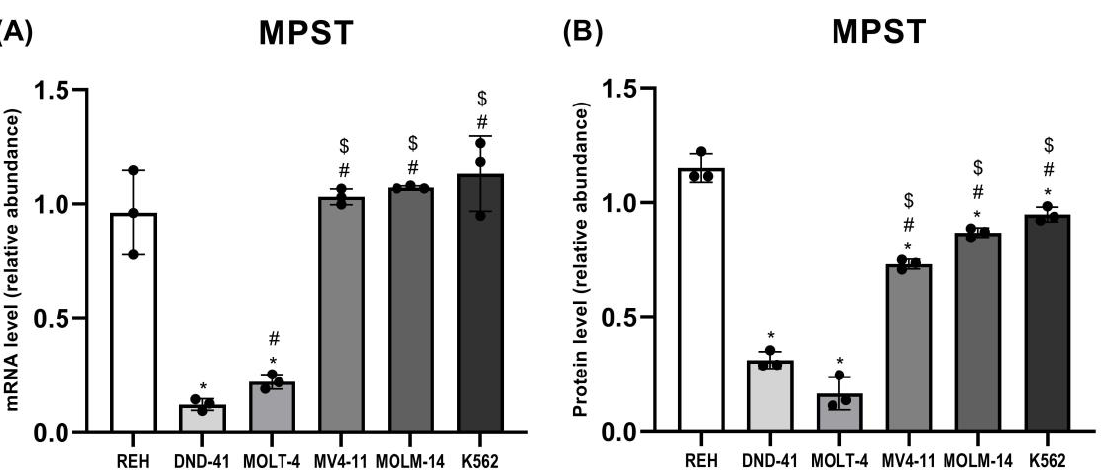
Figure 5. The expression on the mRNA ( A ) and protein ( B ) level of 3-mercaptopyruvate sulfurtrans- ferase in leukemia cell lines (REH, DND-41, MOLT-4, MV4-11, MOLM-14, K562). β -Actin was used as a loading control. Quantification of the MPST expression on mRNA level (RT-PCR method) and protein level (Western blotting method) was performed by densitometric analysis of the gels/blots and normalized to the internal loading control. The results are expressed as the mean ± SD of three or more independent experiments. Each mark represents p < 0.05 as followed: * versus REH; # versus DND-41; $ versus MOLT-4.